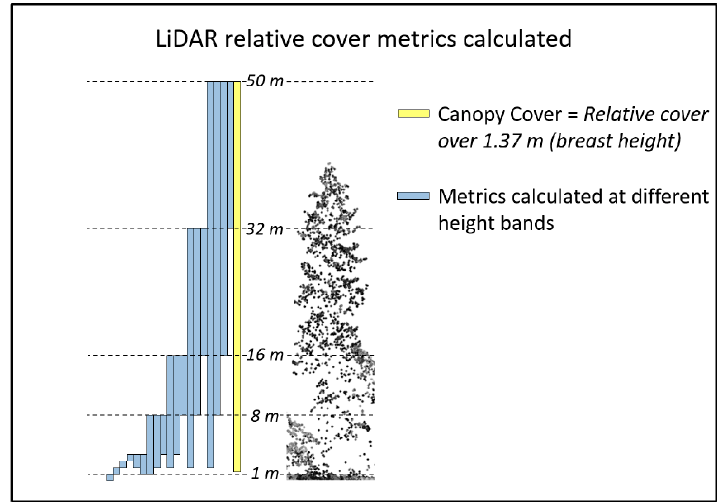
Figure 6. Pictorial representation of the 20 relative percent cover metrics calculated from our LiDAR data. Each vertical bar represents a different height range for which relative percent cover was calculated. For example, the most familiar metric is the percent cover, shown in yellow in the figure above. This metric is calculated as the number of LiDAR hits over breast height (1.37–50 m) divided by the total number of LiDAR hits. These 20 metrics represent only a portion of LiDAR-derived metrics calculated, in addition to basic point statistics and percentile heights. These relative percent cover values were calculated for both first and all LiDAR returns (representing 40 of the 54 metrics calculated).